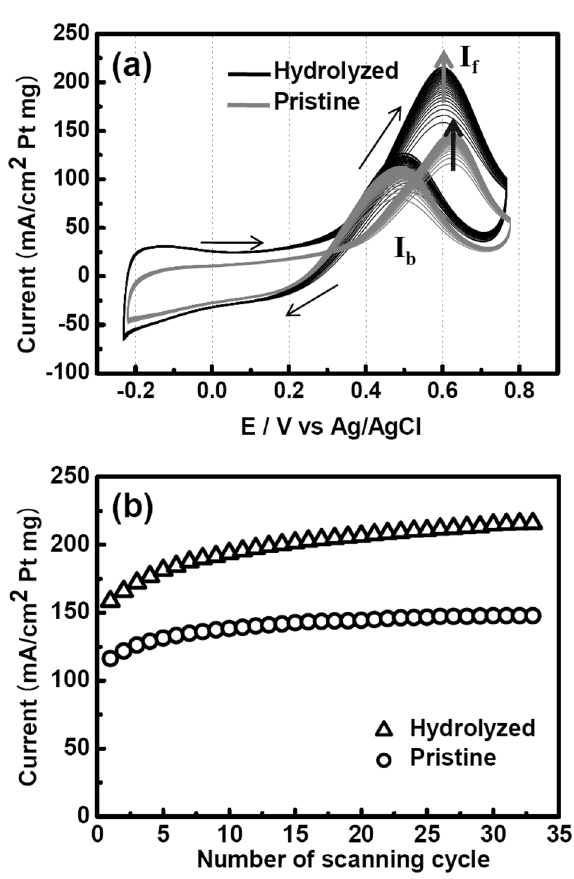
Figure 7. ( a ) Cyclic voltammetry of pristine and hydrolysed PAN-based nanofibers with Pt catalysts. ( b ) Long- term electrocatalytic cycling stability of Pt-loaded PAN-based